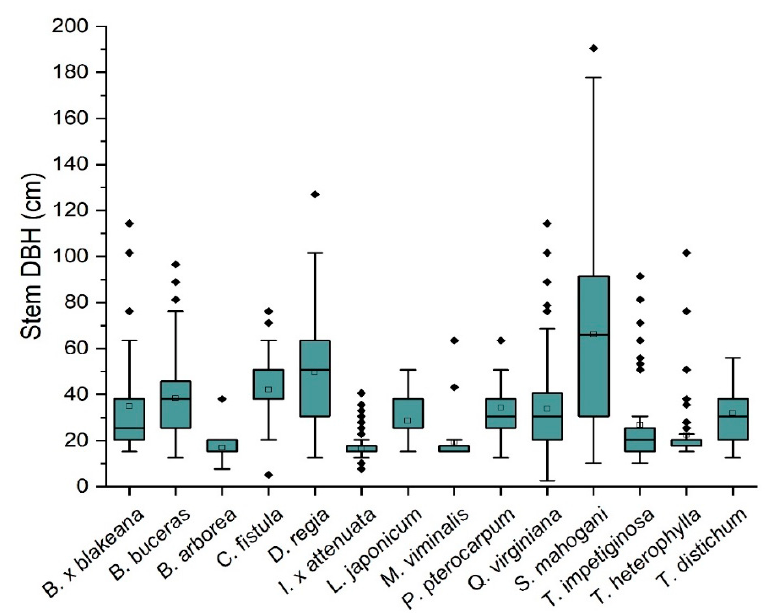
Figure 1. Box and whisker plot for stem diameter 1.4 m above ground (DBH) of species listed in Table 1, except Ficus retusa L., which was not included because of the presence of aerial roots. Complete binomials are in Table 1. Means represented as square symbols and outliers represented as rhombus symbols.